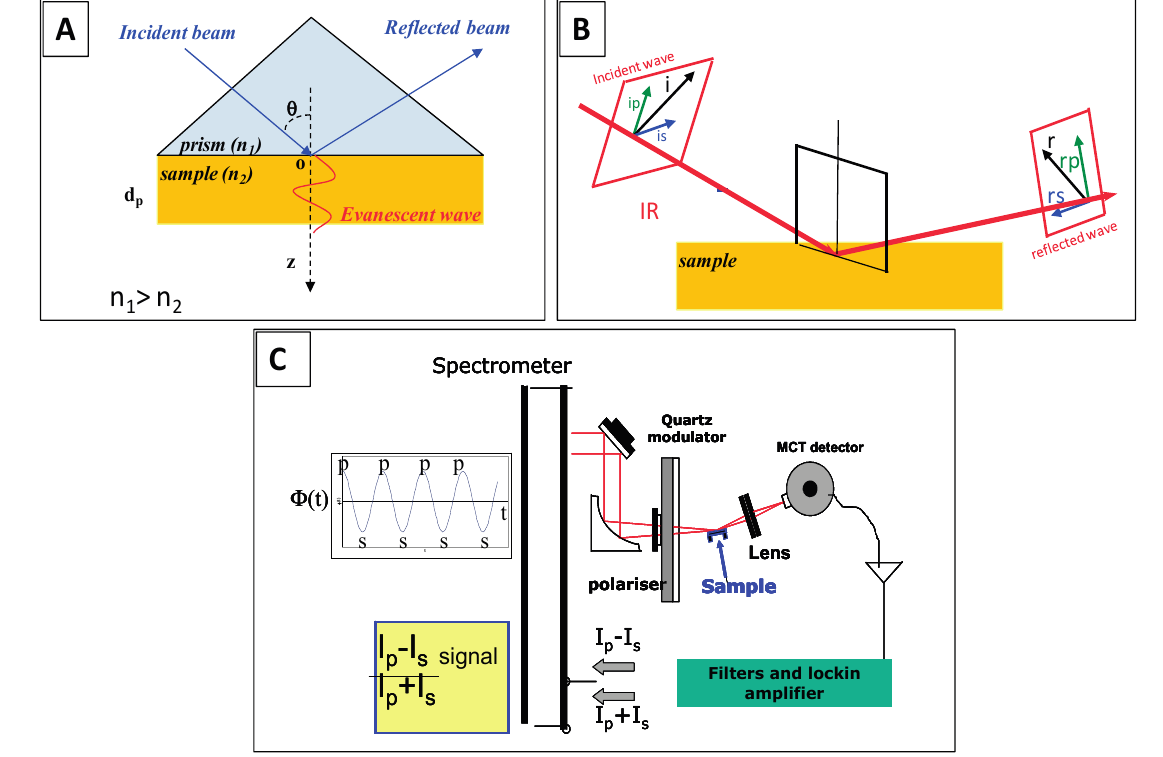
Figure 1. Surface IR spectroscopy techniques: ( A ) principle of Attenuated Total Reflection InfraRed (ATR-IR); ( B ) principle of (phase-modulated) InfraRed Reflection Absorption Spectroscopy (IRRAS/PM-IRRAS); and ( C ) experimental setup for PM-IRRAS